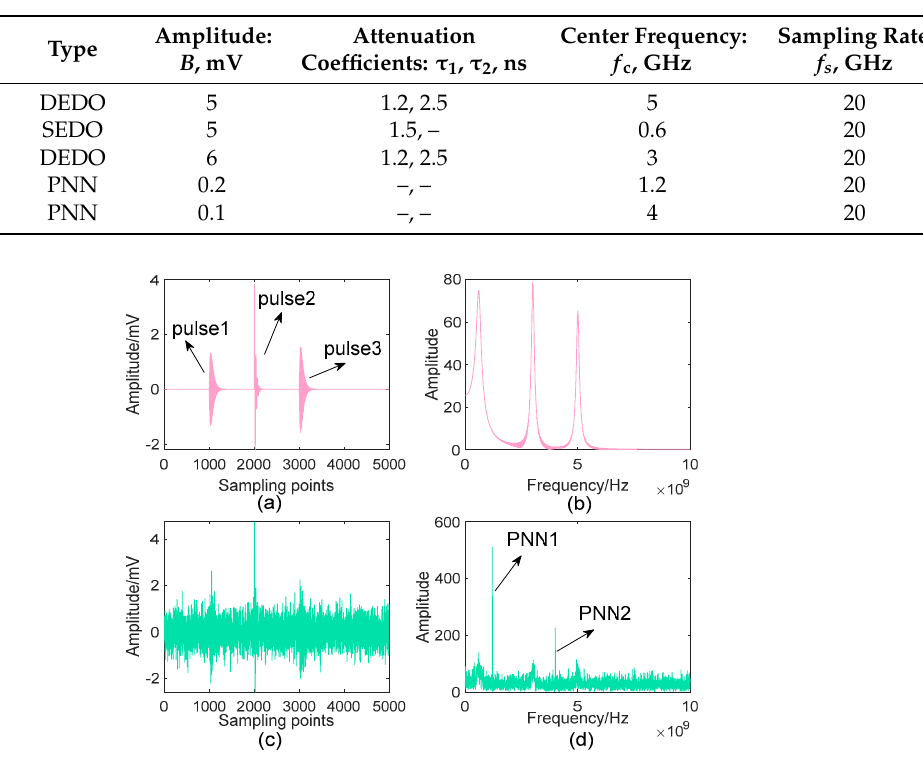
Figure 3. Synthetic UHF PD signal and its spectrum: (a) Pure signal; (b) Spectrum of the pure signal; (c) Noisy signal; (d) Spectrum of the noisy signal.